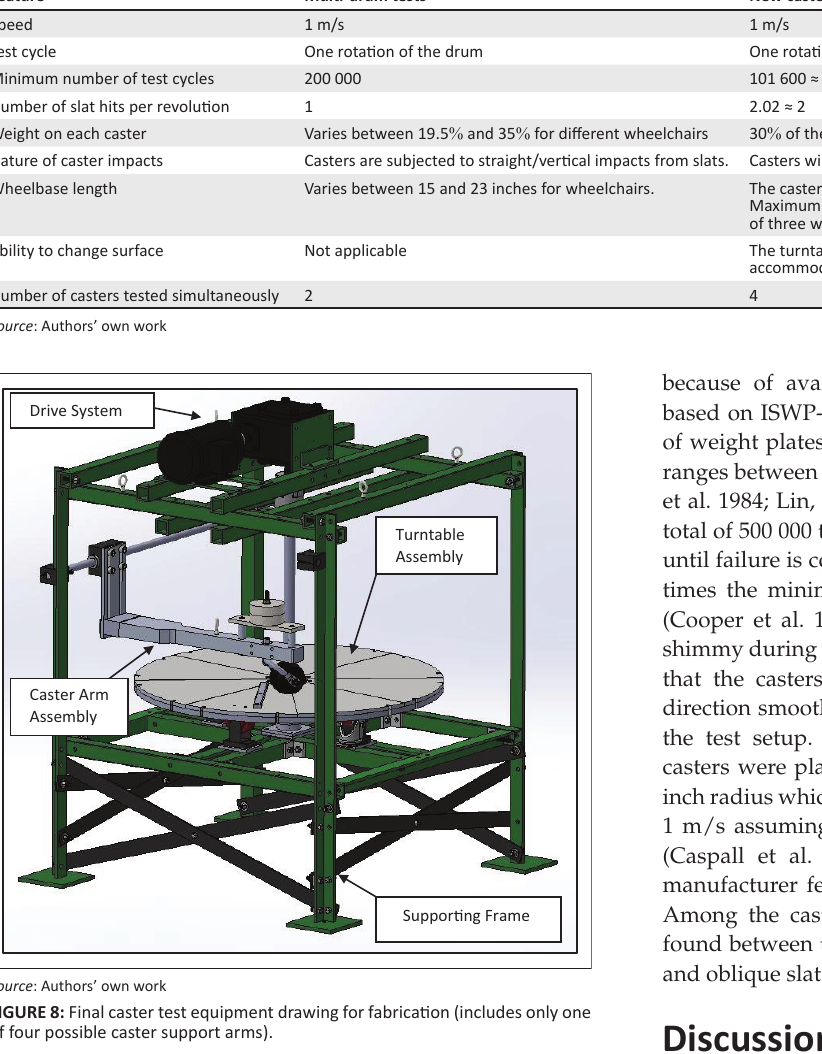
TABLE 4: Specifications of multi-drum tests and new caster assembly test design. Feature